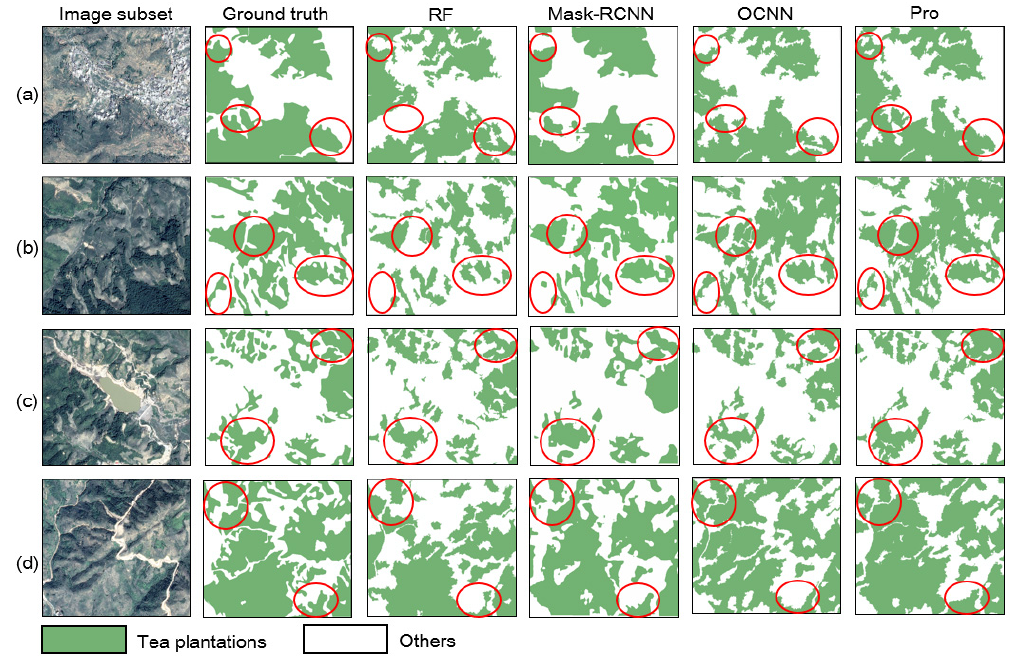
Figure 6. Classification results obtained by the RF, Mask R-CNN, OCNN, and the proposed method (labeled as Pro) on four datasets ( a – d